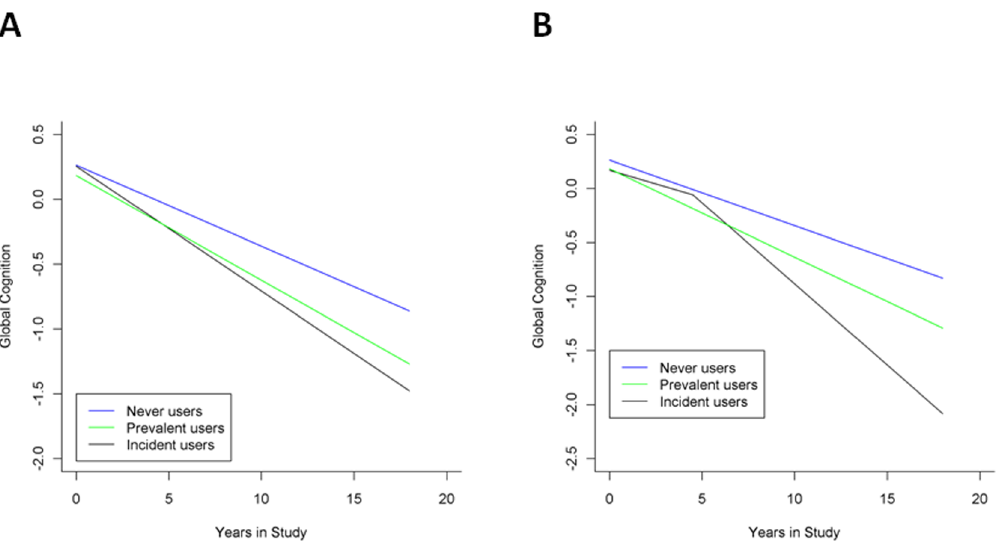
Figure 1. Estimated global cognitive performance (z-score units) as a function of time in study. Figure 1A shows results from a mixed- effects model without a change point added for initiation of a medication with anticholinergic activity and Figure 1B shows results from a model with a change point. The blue line shows average global cognitive performance over time for a typical person (75-year-old female with 18 years of education) who never used an anticholinergic medication. The green line shows average cognitive function over time for a typical person who was taking a medication with anticholinergic activity at baseline. The black line shows average global cognitive function over time for a typical person who first started anticholinergic medication after 4.5 years.